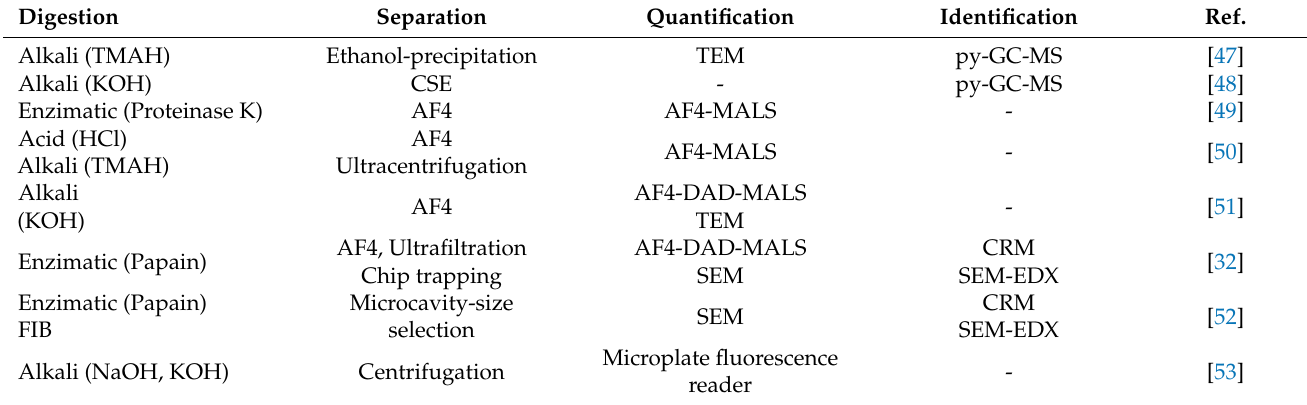
Table 4. Methods for the detection of NPs in biological samples. TEM: transmission electron microscopy; SEM: scanning electron microscopy; py–GC–MS: pyrolysis–gas chromatography–mass spectrometry; CSE, coagulation-sedimentation extraction; AF4, asymmetrical flow-field fractionation; DAD, diode array detector; MALS, multiangle light scattering detector; CRM, confocal Raman spectroscopy; EDX, energy-dispersive X-ray; FIB, focused ion